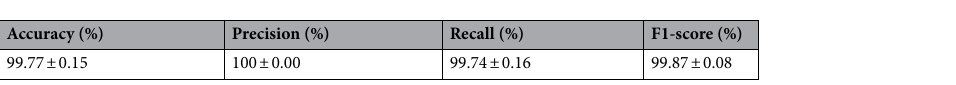
Figure 4. Accuracy and loss curves in training progress for the ResNet18 model; ( A ) accuracy is plotted versus the training iteration for both training and validation data, ( B ) cross-entropy loss is plotted versus the training iteration for both training and validation data. Training plots were smoothed to better visualize trends.